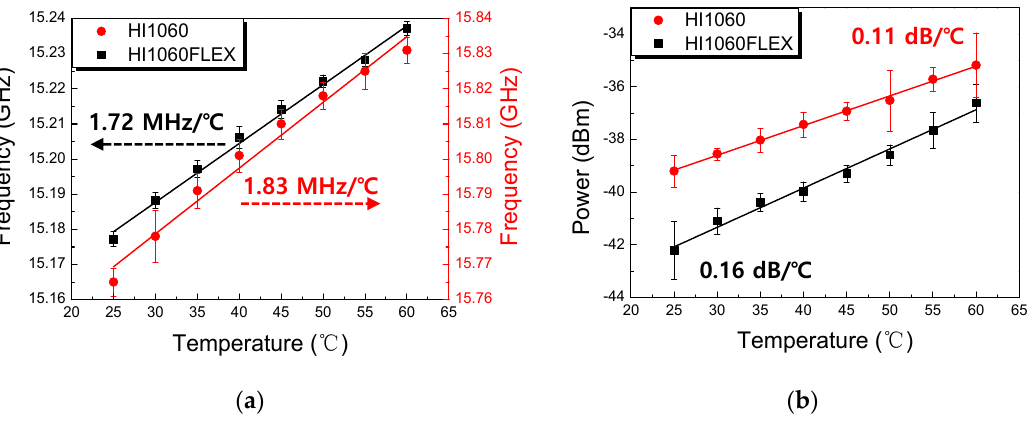
Figure 6. Temperature-dependent Brillouin peak parameters for HI1060 and HI1060FLEX fibers with the incident power of 55 mW. ( a ) The Brillouin frequency ν B and ( b ) the peak power. The fiber lengths were 500 m.